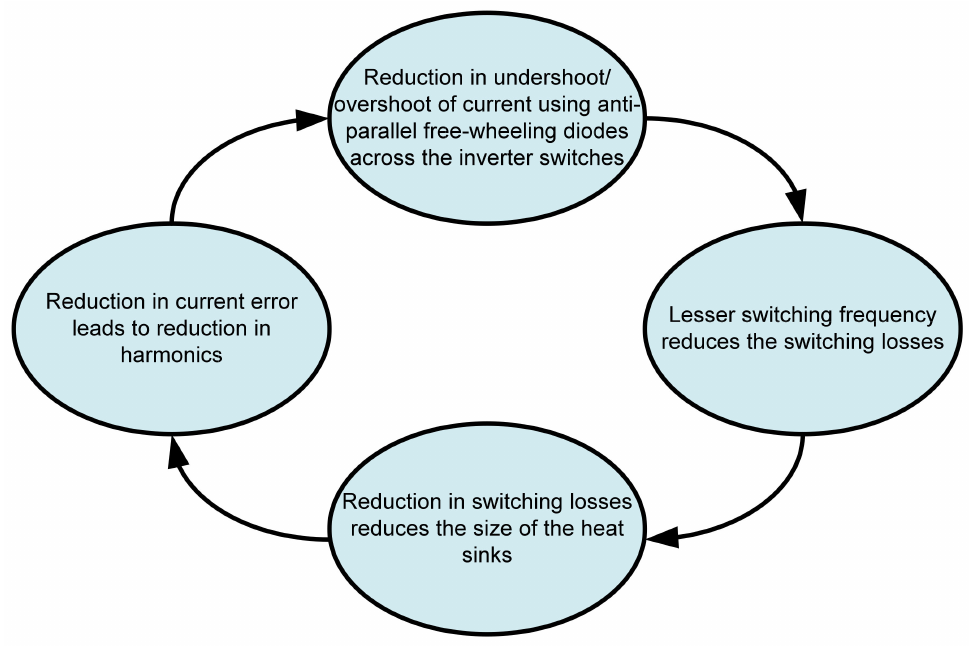
Figure 1. Advantages of offset hysteresis band current controller